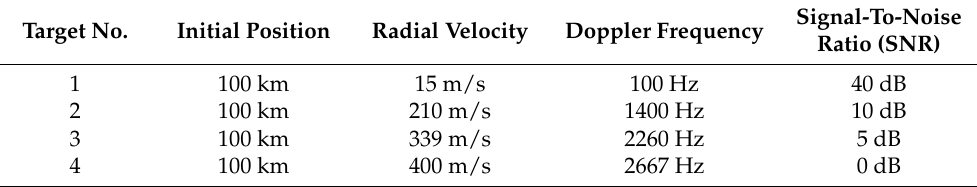
Table 3. Basic information of the targets set in Scenario 2.